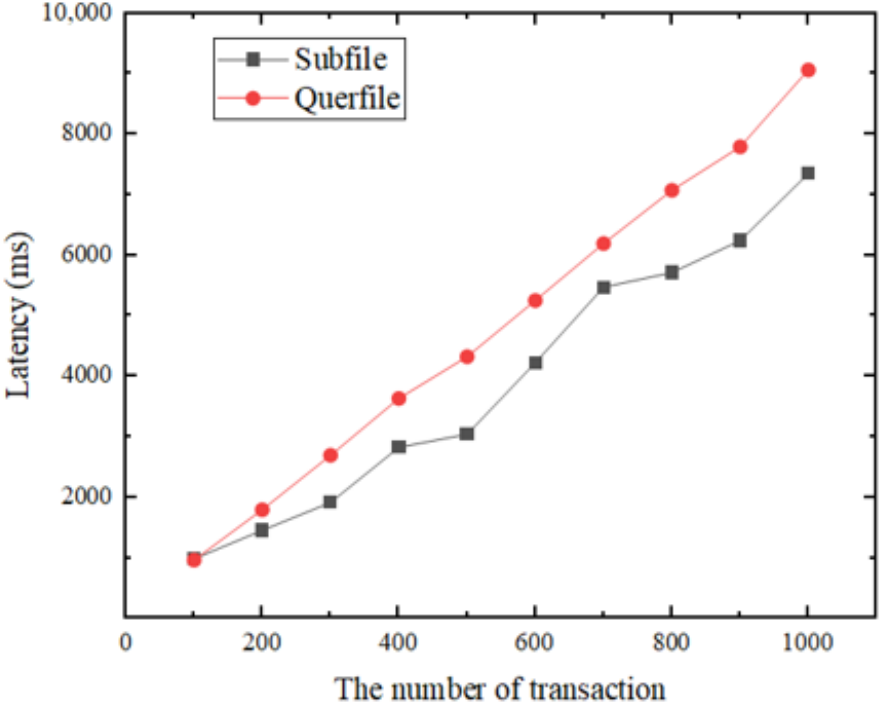
Figure 9. System latency at different transaction volumes.